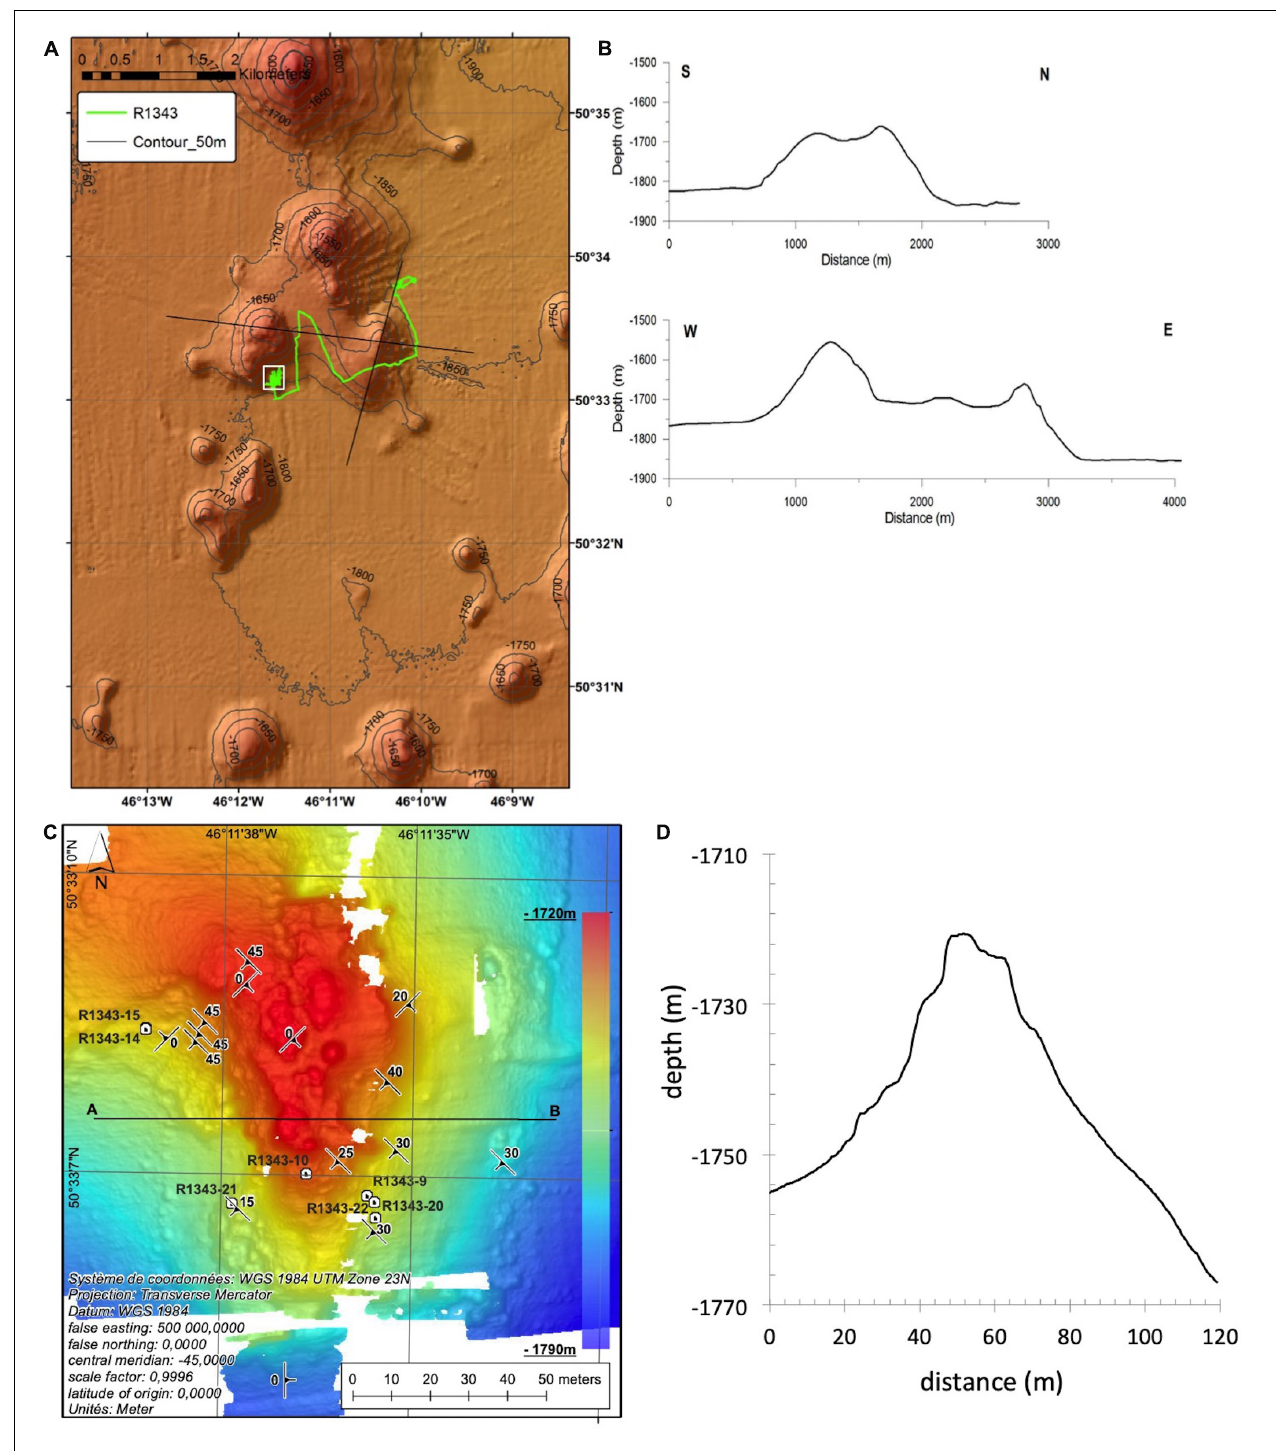
FIGURE 7 | Detailed bathymetry of the mound complex on NE Orphan Knoll, including the site of the coral graveyard collection. (A) ICY-LAB multibeam sonar of mounds,including mounds surveyed on ROPOS dive R1343. Multibeam bathymetry gridded to 25 m. (B) Bathymetric profiles across one (N–S) and two (W–E profile) mounds in 25 m grid bathymetry. The West-to East profile line crosses both mounds surveyed on dive R1343. VE = 2. (C) Detailed of bathymetry of the mound sampled in ROPOS dive R1343, also showing strike and dip measurements and locations of rock sample collections (see Supplementary Table 1 ). (D) Bathymetric profile A–B across ridge-shaped portion of mound surveyed with near-bottom multibeam sonar. VE = 2.